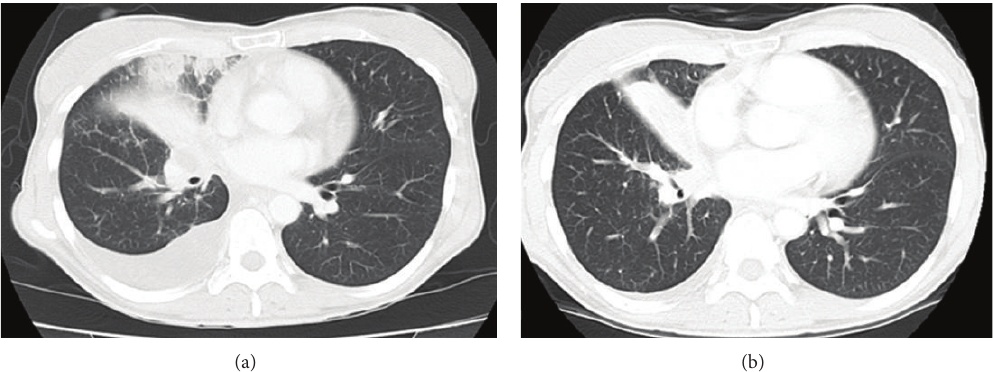
Figure 2: Chest computed tomography (CT) scan before treatment (a) and a month after gefitinib initiation (b). Size reduction of the primary tumor and disappearance of right-sided pleural effusion were